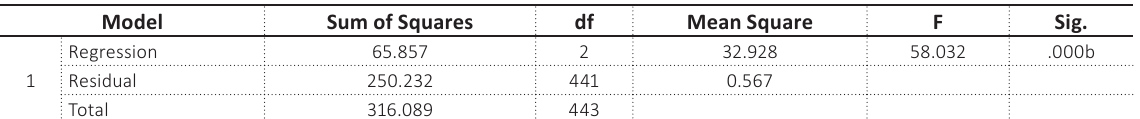
Table 8. ANOVA a for H